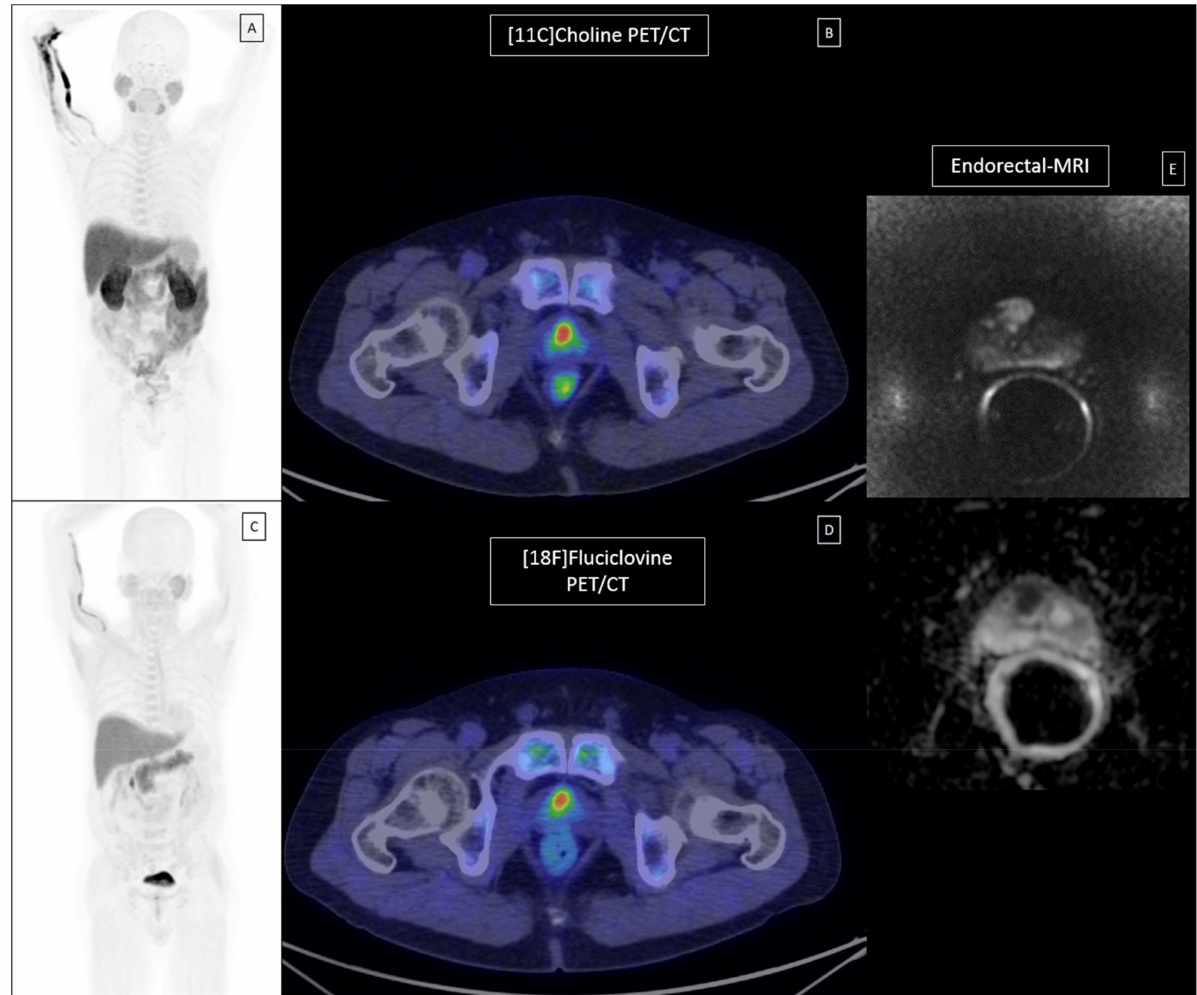
Figure 4. Concordant [ 11 C]Choline, [ 18 F]Fluciclovine PET/CT and mpMRI in a ISUP 5 PCa lesion. ( A ) A patient affected by high-risk primary Pca underwent conventional [ 11 C]Choline PET/CT (A-mip; B- axial fused PET/CT), additional investigational [ 18 F]Fluciclovine PET/CT (C-mip; D-axial fused PET/CT) and conventional mpMRI (E- axial DWI and ADC) before RP. ( B ) Staging imaging resulted positive in middle-apex right prostate lobe in all cases, corresponding with the most aggressive high-grade lesion (pGS 4 + 5; pISUP5). ( C ) The lesion uptake was clearly above the bone marrow background (measured at L3 vertebral body) with both tracers. ( D ) A further millimetric malignant focus of pGS 3 + 3 was identified at histopathological analyses but it was not detected at